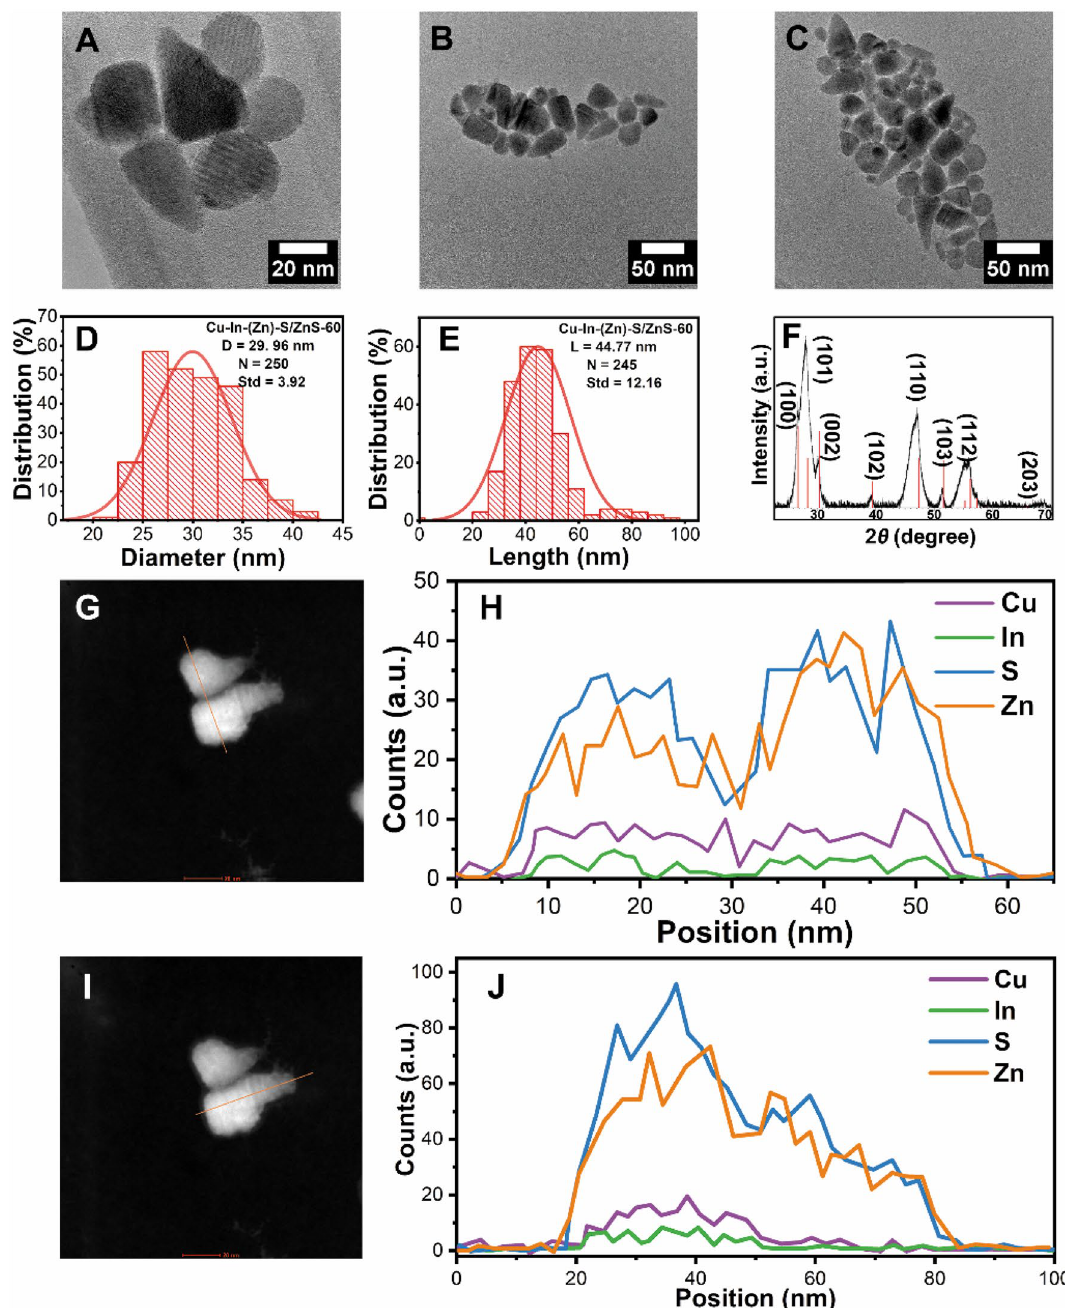
Figure 3. ( A – C ) TEM images, ( D ) Diameter histogram, ( E ) Length histogram and ( F ) XRD diffraction pattern (The red lines indicate the reference PDF 75-1547 ZnS) of the sample Cu–In–(Zn)–S/ZnS-60. ( G , H ) STEM image and corresponding line scanning spectra following the direction of the orange line in ( G ). ( I , J ) STEM image and the corresponding line scanning spectra of the orange line in ( I